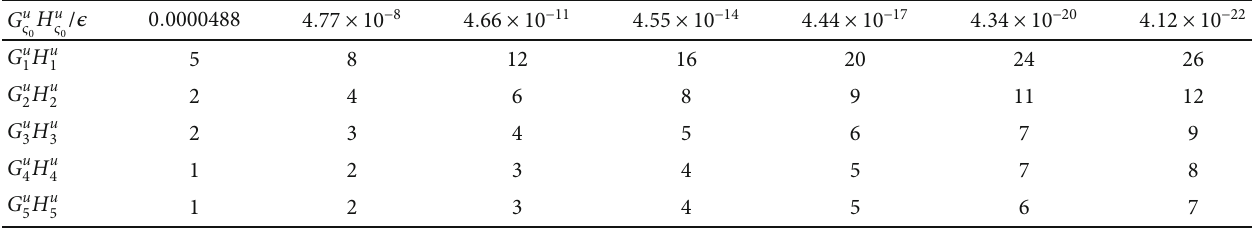
Table 4: Subdivision depth of uniform Doo-Sabin subdivision surface at valence n = 6